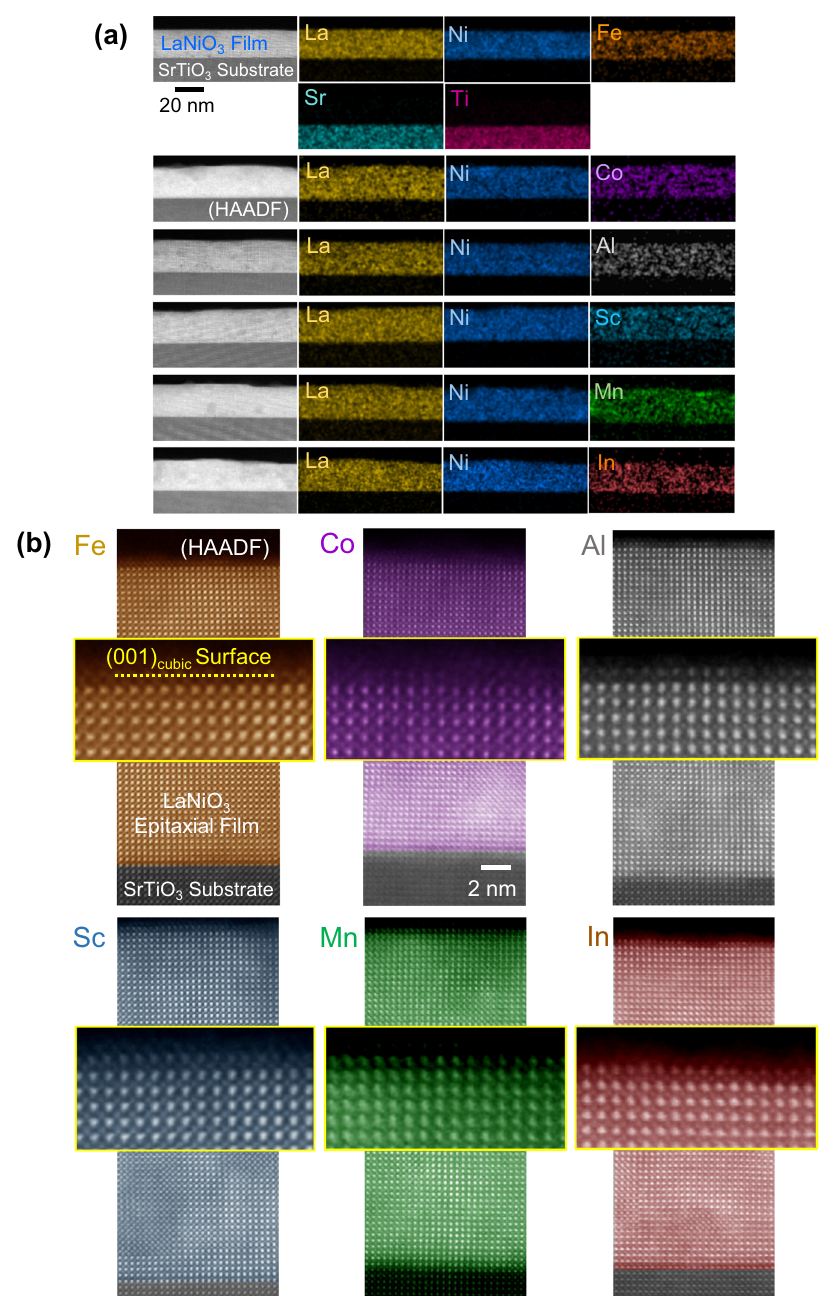
Fig. 3 Fabrication of LaNiO 3 heteroepitaxial (001) cubic thin fi lms with dopants. a A series of EDS maps is provided to verify the homogeneous distribution of the dopants in the fi lms. The doping level was adjusted to be 10%. b HAADF images and their enlargements for the surface region are shown to directly con fi rm both the heteroepitaxy and the clean (001) surface of the fi lms on SrTiO 3